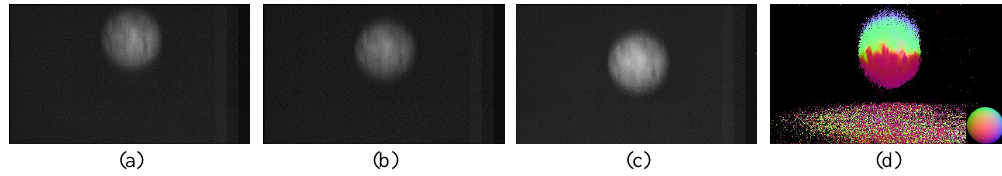
Figure 2. Results of use of classical photometric stereo method for a dynamic scene of a falling ball. ( a – c ) represent the three captured images with different lighting directions. The positions of the falling ball do not correspond in the images shown in ( a – c ). ( d ) shows the normal map, which is incorrect because the classical photometric stereo method assumes that intensity changes in captured images only come from changes in the lighting conditions. Note that the colors in the estimated image indicate the normal directions of the colored sphere, as shown at the bottom